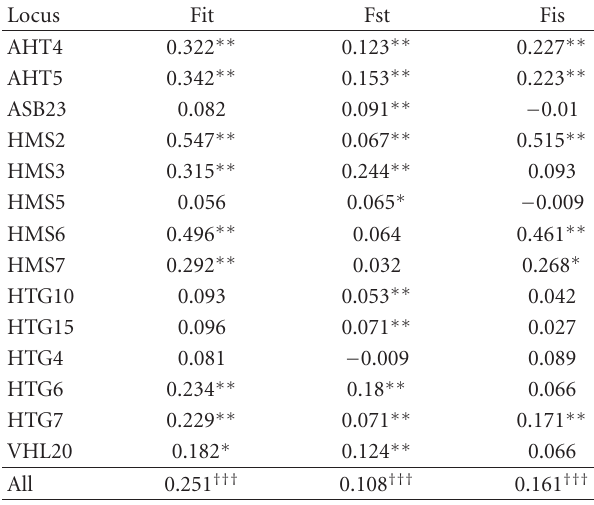
Table 2: F -statistics (Fit, Fst, and Fis) per locus and overall the three Sicilian donkey breeds.